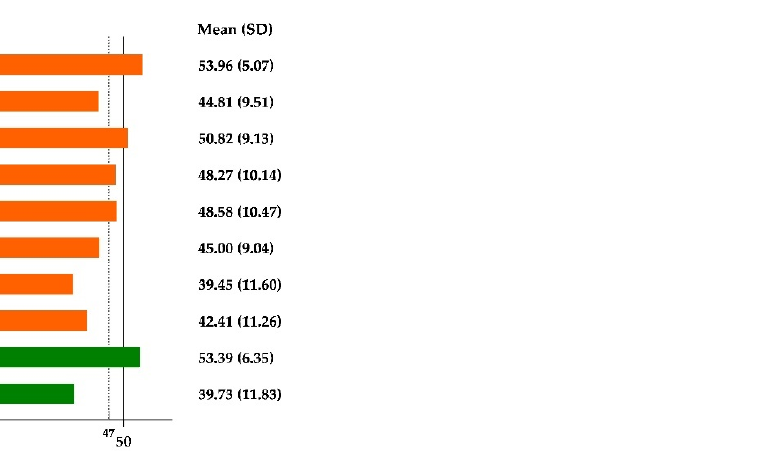
Figure 1. Mean scores of each SF-36v2 subscale and domain following the COVID-19 pandemic outbreak (n = 193). (PF: physical functioning; RP: role-physical; BP: bodily pain; GH: general health; VT: vitality; SF: social functioning; RE: role-emotional; MH: mental health; PCS: physical component summary; MCS: mental component summary; SD: standard deviation). Table 2. Participants’ descriptive characteristics contributing to PCS and MCS scores (n =